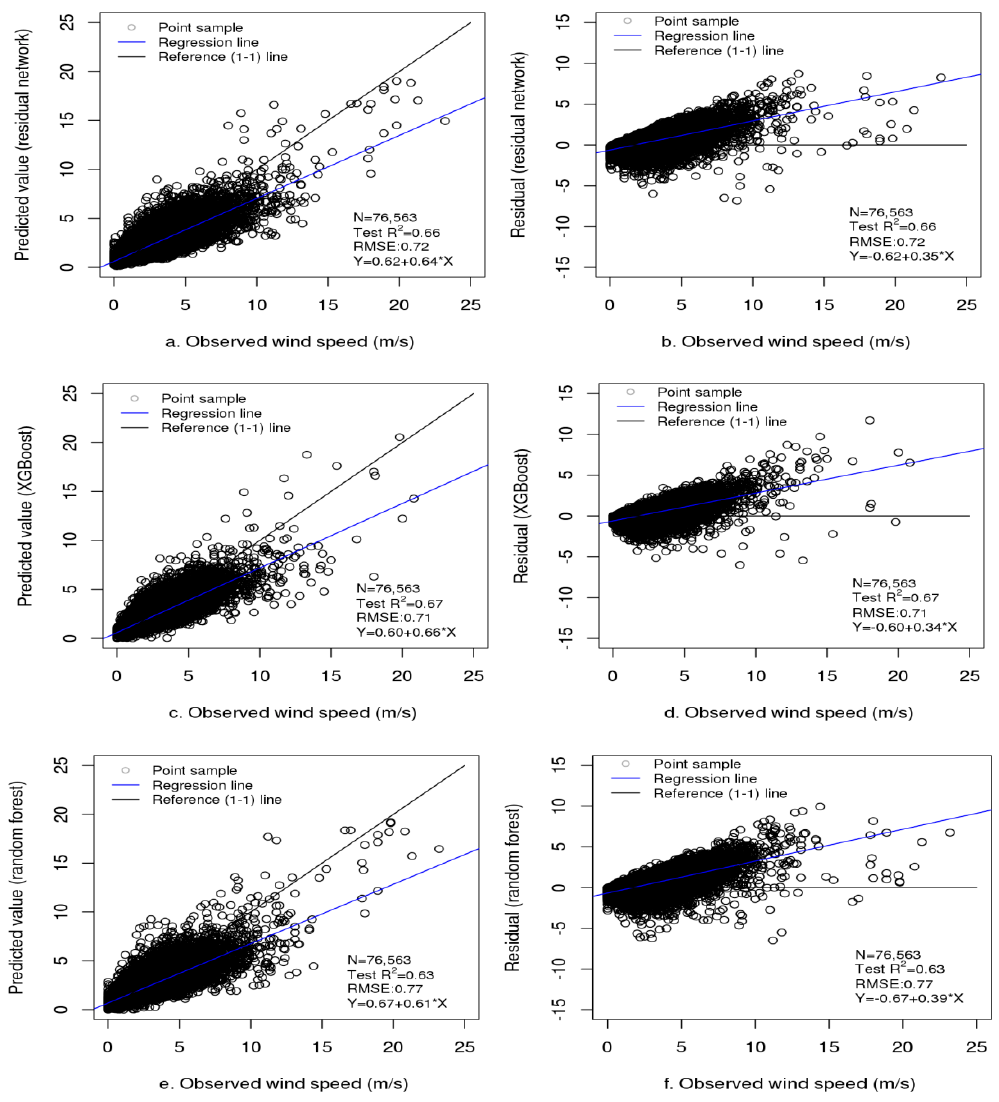
Figure 7. Plots of observed values ( a , c , e ) and residuals ( b , d , f ) vs. predicted values of wind speed for autoencoder-based residual network ( a , b ), XGBoost ( c , d ) and random forest ( e , f ) for the independent tests.